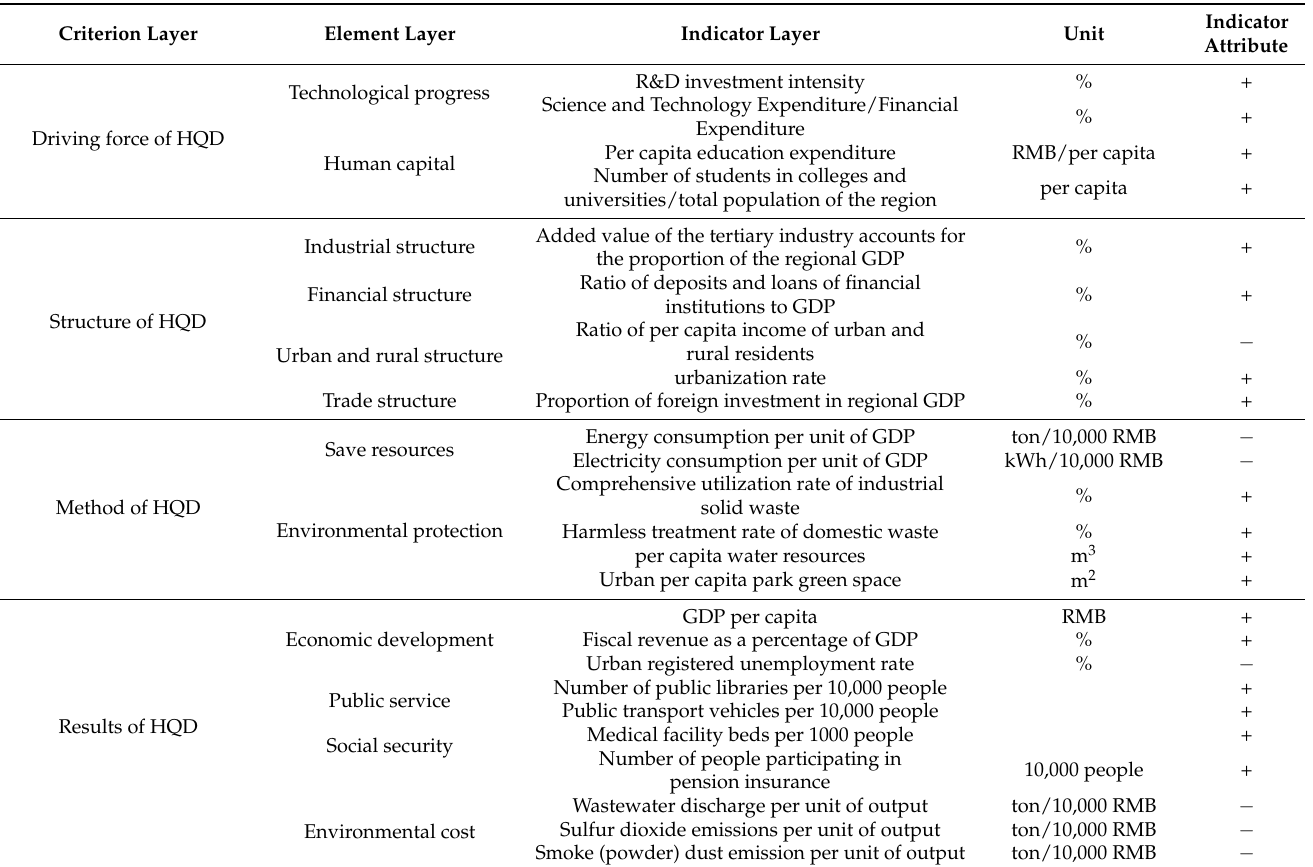
Table 1. Index system for evaluating the level in the Yellow River